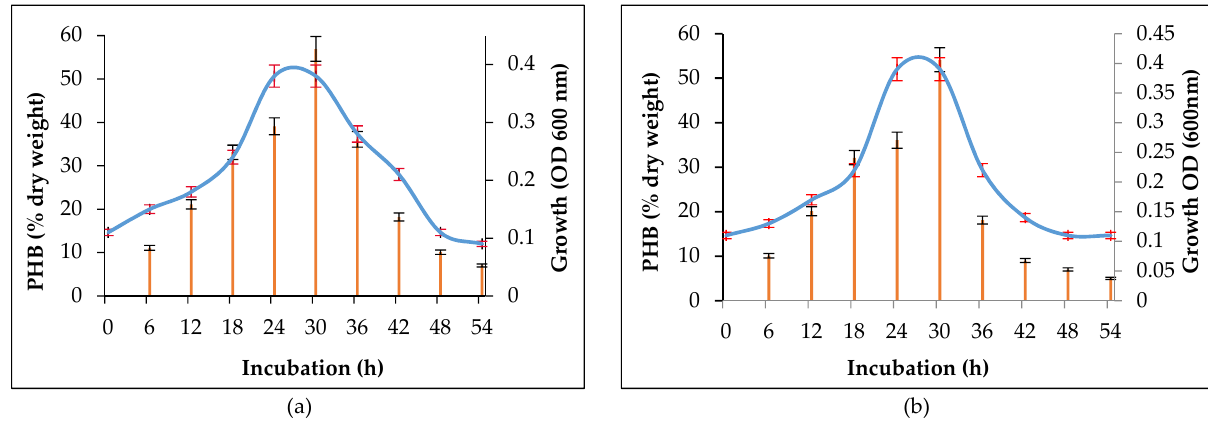
Figure 2. ( a ) Growth and PHB accumulation in A. faecalis RZS4) during growth in NDM broth at 30 °C for 48 h at 120 rpm. ( b) Growth and PHB accumulation in Pseudomonas sp. RZS1 during growth in NDM broth at 30 °C for 48 h at 120 rpm. Samples were withdrawn at 6 h intervals and were subjected to the estimation of cell growth and PHB.